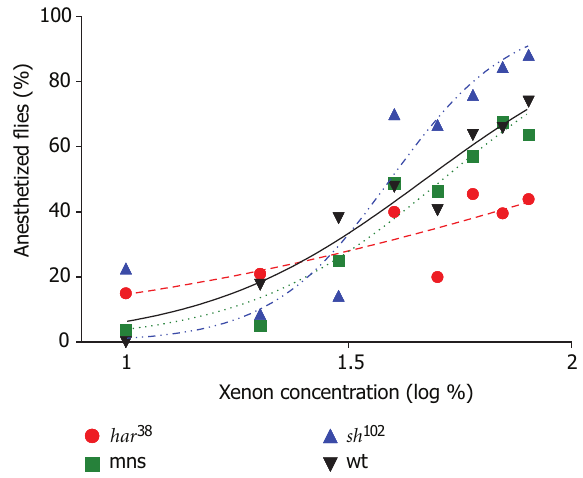
Figure 1: Percentage of anesthetized flies at di ff erent concentrations of xenon. Dots show the actual measured data points; lines show the best-fit sigmoidal curve for these data points. Note that the y -axis has a logarithmic scale.